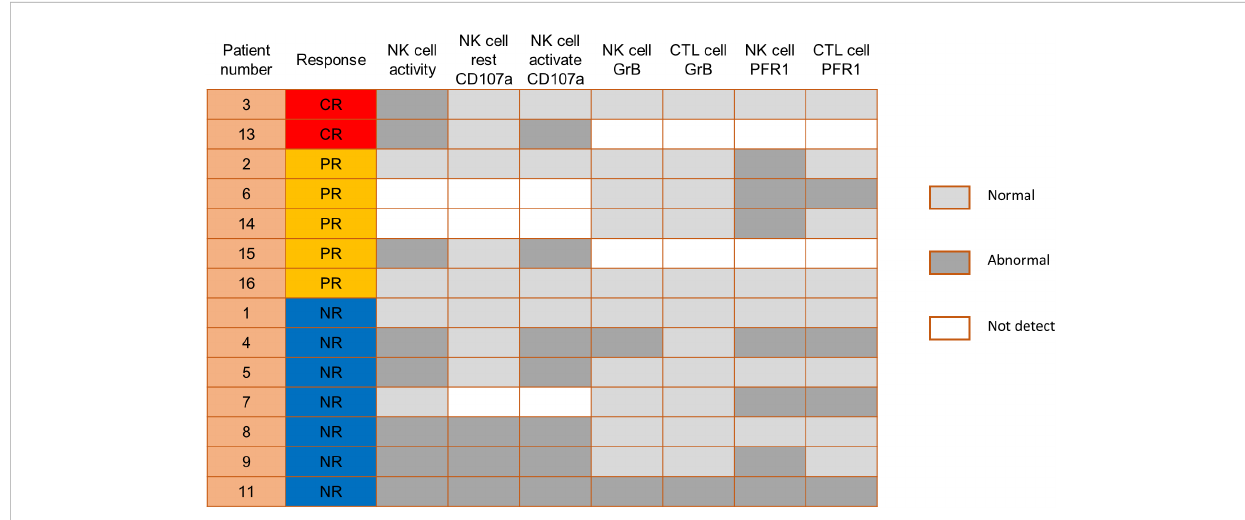
FIGURE 3 Comparison of NK cell function before PD-1 inhibitor infusion according to responses. CTL, cytotoxic T cell; GrB, granzyme B; PFR1, perforin